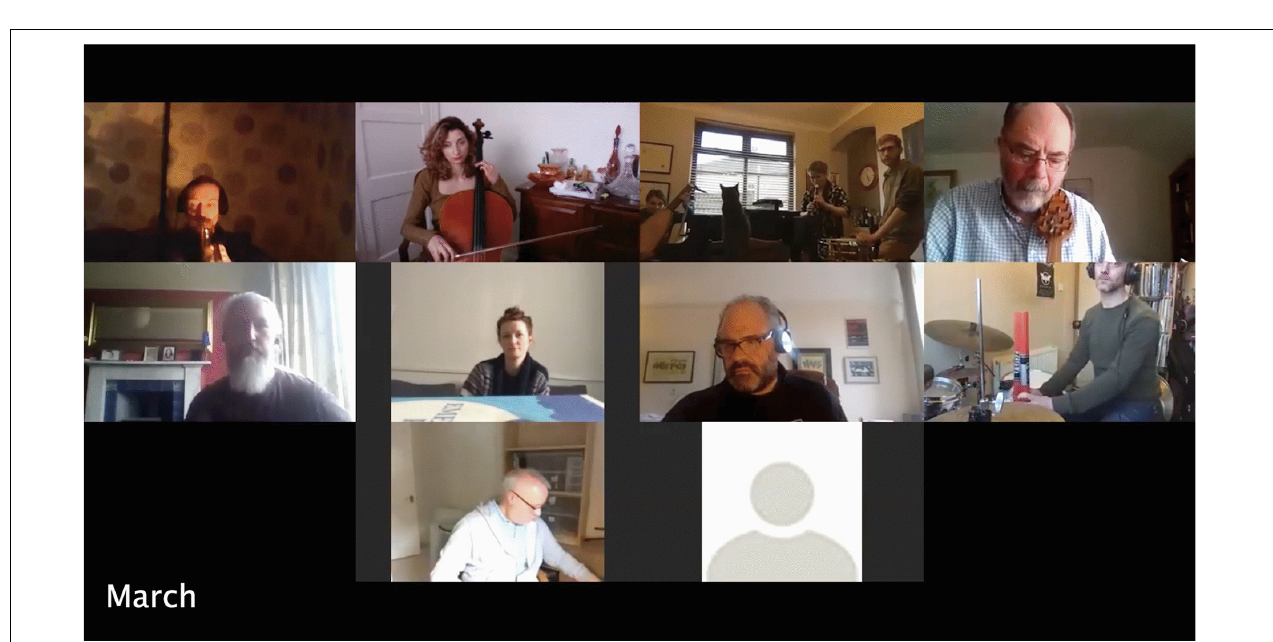
FIGURE 10 | Showing object/home/instruments 2. The Gif version, highlighting musicians’ movement, can be found in the Supplementary Material .